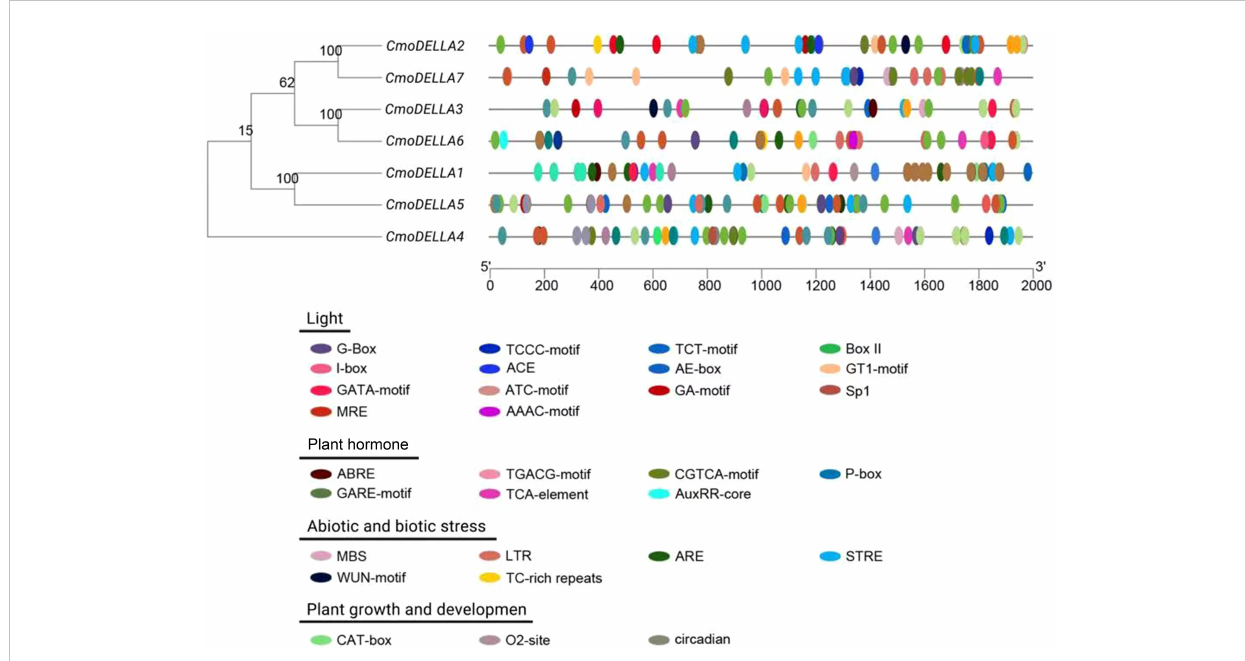
FIGURE 5 Cis -regulatory elements in the promoter regions of CmoDELLA genes. These cis -regulatory elements are related to light response, plant hormone response, stress response, and plant growth and development. The different colored circles represent the different types and positions of cis - regulatory elements in each CmoDELLA